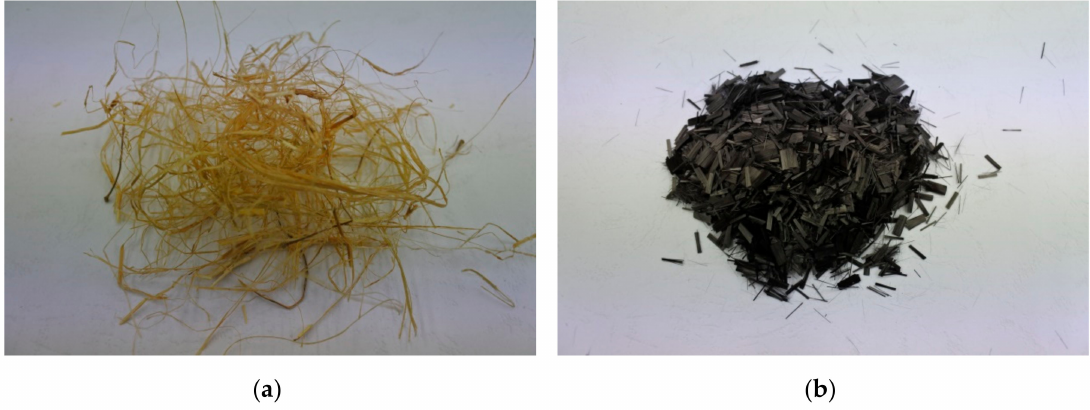
Figure 1. ( a ) The green tow flax fibers; ( b ) The carbon